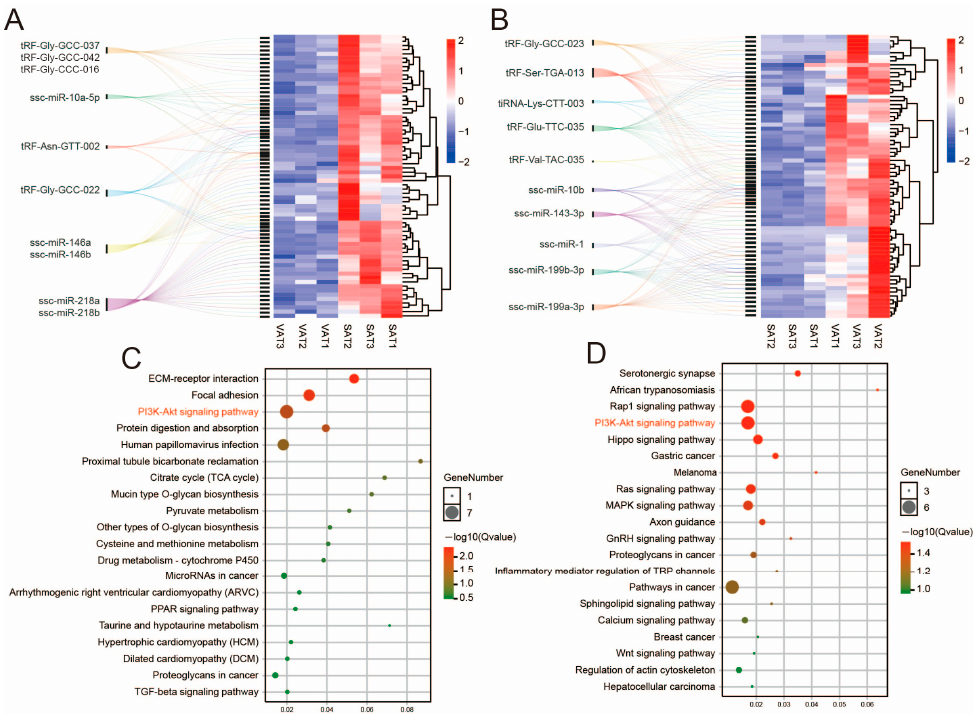
Figure 5. tsRNA/miRNA/mRNA co-expression network. ( A , B ) Mulberry leaf plot of the tsRNA/miRNA/mRNA co-expression network based on high mRNA expression in SAT ( A ) or VAT ( B ). ( C , D ) KEGG analysis of mRNAs highly expressed in SAT ( C ) or VAT ( D ) in co-expression networks.